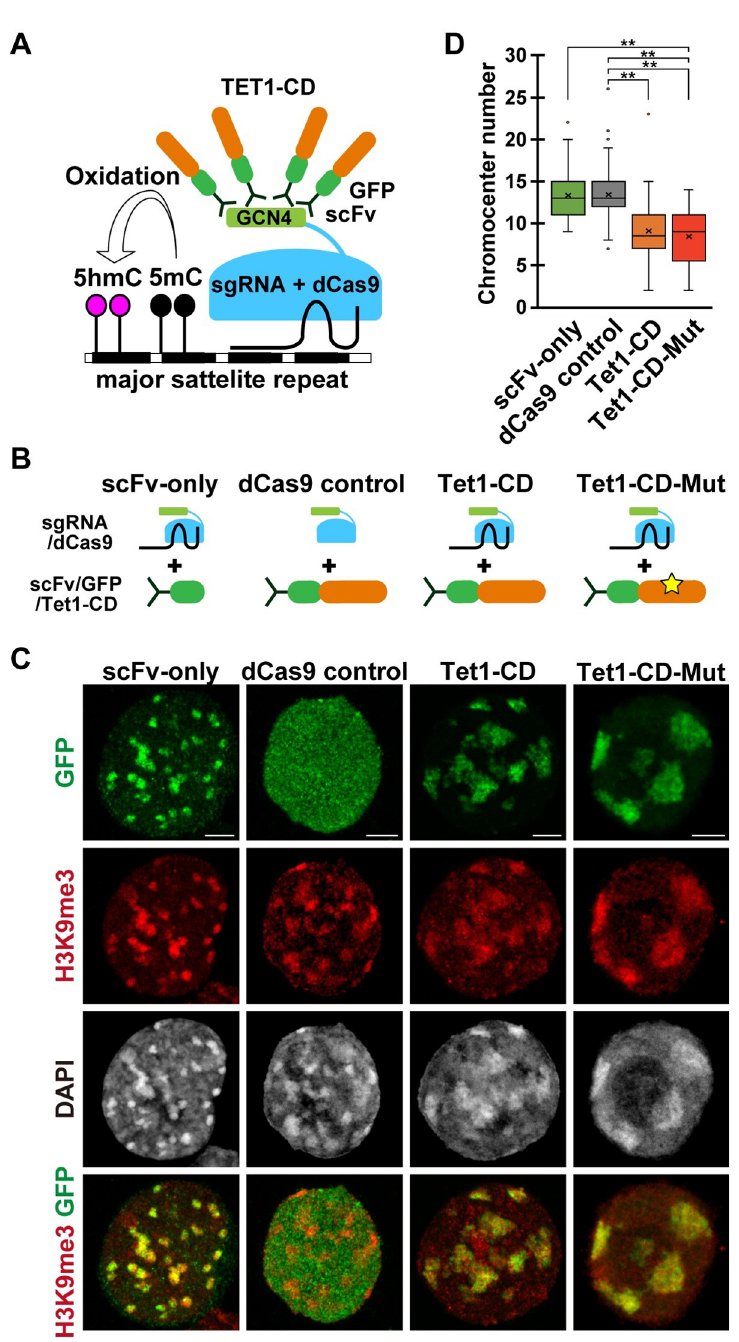
Fig 2. Forced recruitment of TET1-CD to PCH and chromocenter clustering. (A) : Schematic illustration of the experimental design. GCN4 was conjugated with catalytically-dead Cas9 (dCas9), which was recruited to PCH by the sgRNA targeting major satellite repeats, and GCN4 was targeted by scFv conjugated with TET1-CD. (B) : Schematic illustration of experimental conditions. (C) : Representative immunostaining images of the surface-spread nuclei of the ESCs expressing individual cassette. Scale bar, 5 μ m. (D) : Boxplot showing the number of distinct chromocenters in the nuclei of ESCs expressing individual cassette, related to (C). scFv-only, n = 34; dCas9 control, n = 48; TET1-CD, n = 44; TET1-CD-Mut, n = 41. P values were calculated using the Mann-Whitney U-test. ��� P < 0.001.